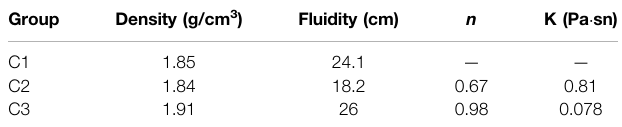
TABLE 5 | Engineering properties of cement slurry.